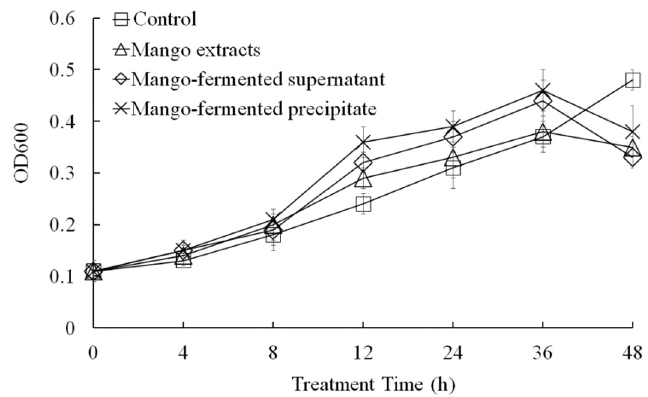
Figure 5. The regulation of L. acidophilus BCRC14079-fermented mango on F. prausnitzii growth. Data are shown as means ± SD ( n = 3). Significant difference was shown by various letters ( p <